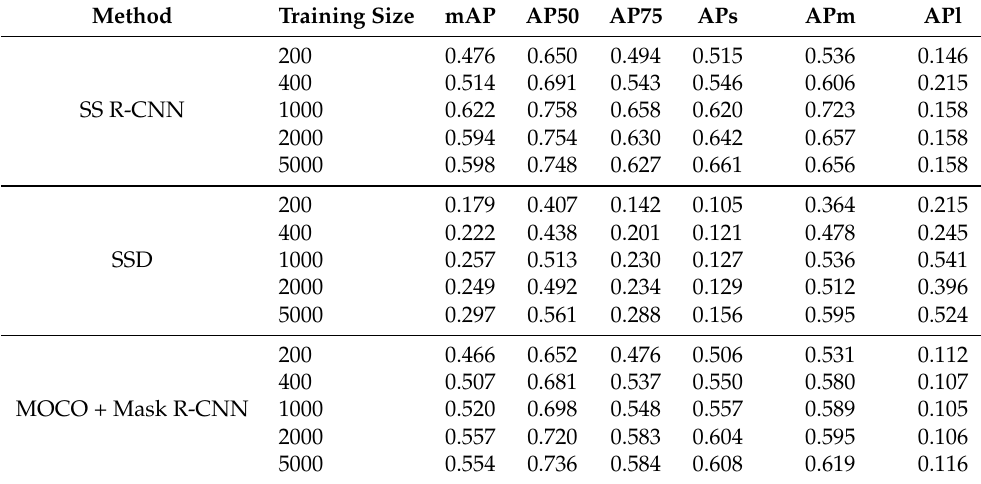
Table 6. Accuracies of SS R-CNN, SSD, and MOCO with varying numbers of labeled training images.